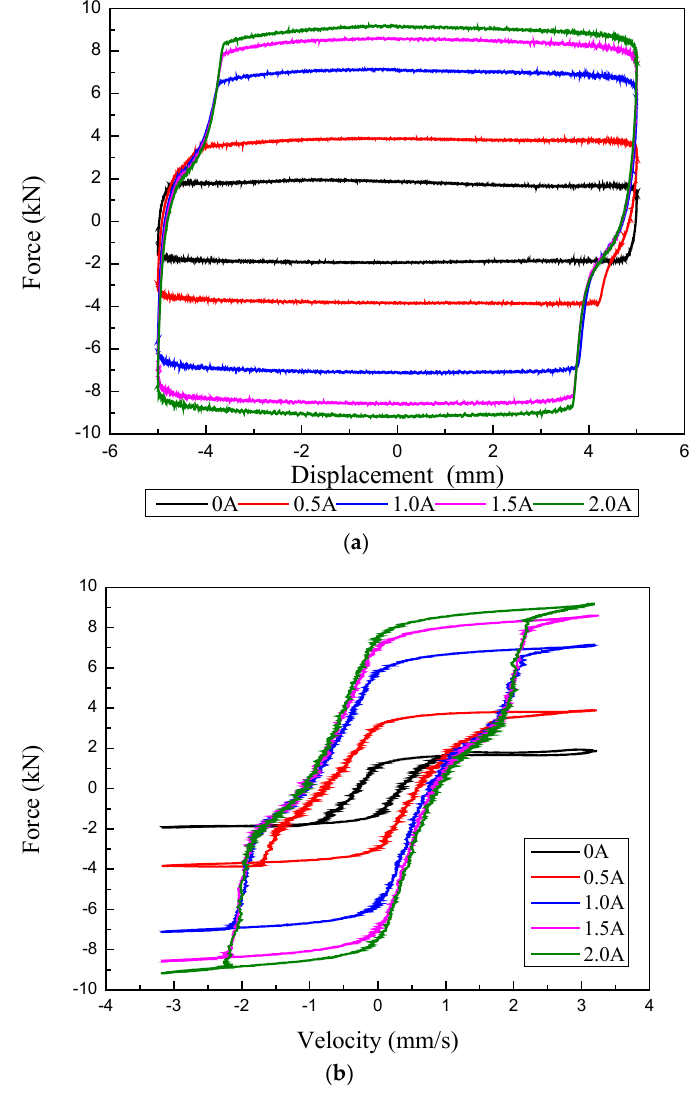
Figure 7. Force–displacement and force–velocity curves. ( a ) Force–displacement curves. ( b ) Force– velocity curves.